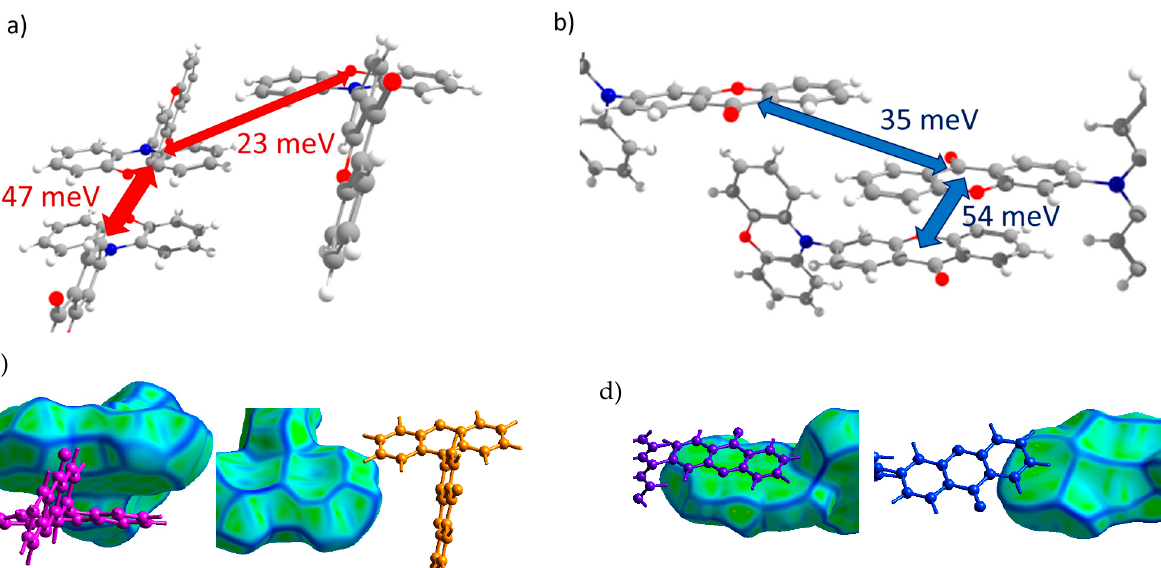
Figure 5. Charge transfer integrals for hole ( a ) and electron ( b ) transport in PXZ-XO crystal. ( c , d ) Intermolecular contacts that enable these transfer integrals; the left picture corresponds to the contact that provided a larger J , while the right picture corresponds to the contact that provided a smaller J . The Hirshfeld surface for the central molecule was mapped with curvedness. The coloring corresponds to Figure 2.